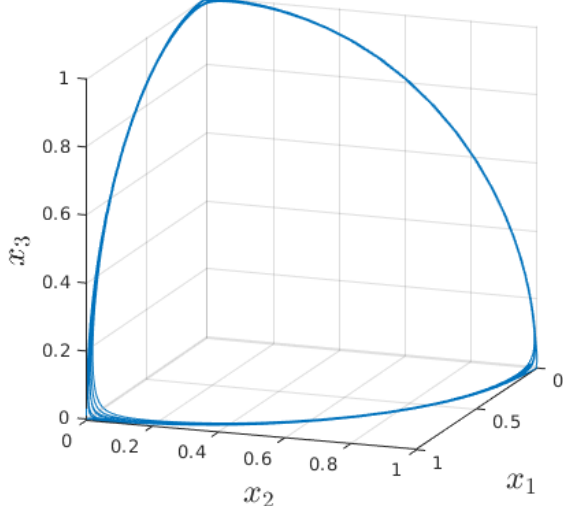
Figure 1. A representation of a PSS built on the SHC networks consisting of three states, each lying on its coordinate axis and connected with multiple